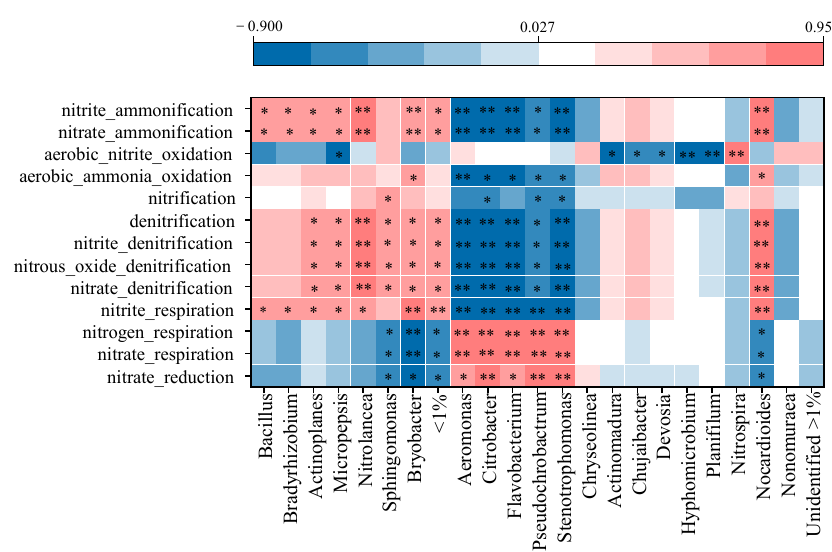
Figure 6. Spearman correlation analysis between N-cycling functions and bacterial community on genus level. * indicates significant correlation at p < 0.05, while ** indicates extremely significant correlation at p < 0.01.